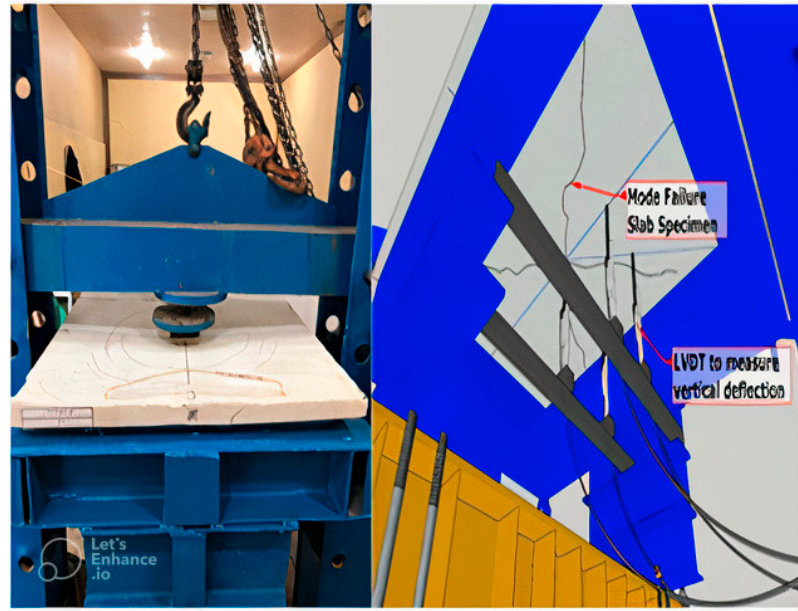
Figure 4. The set-up of the slab testing method.